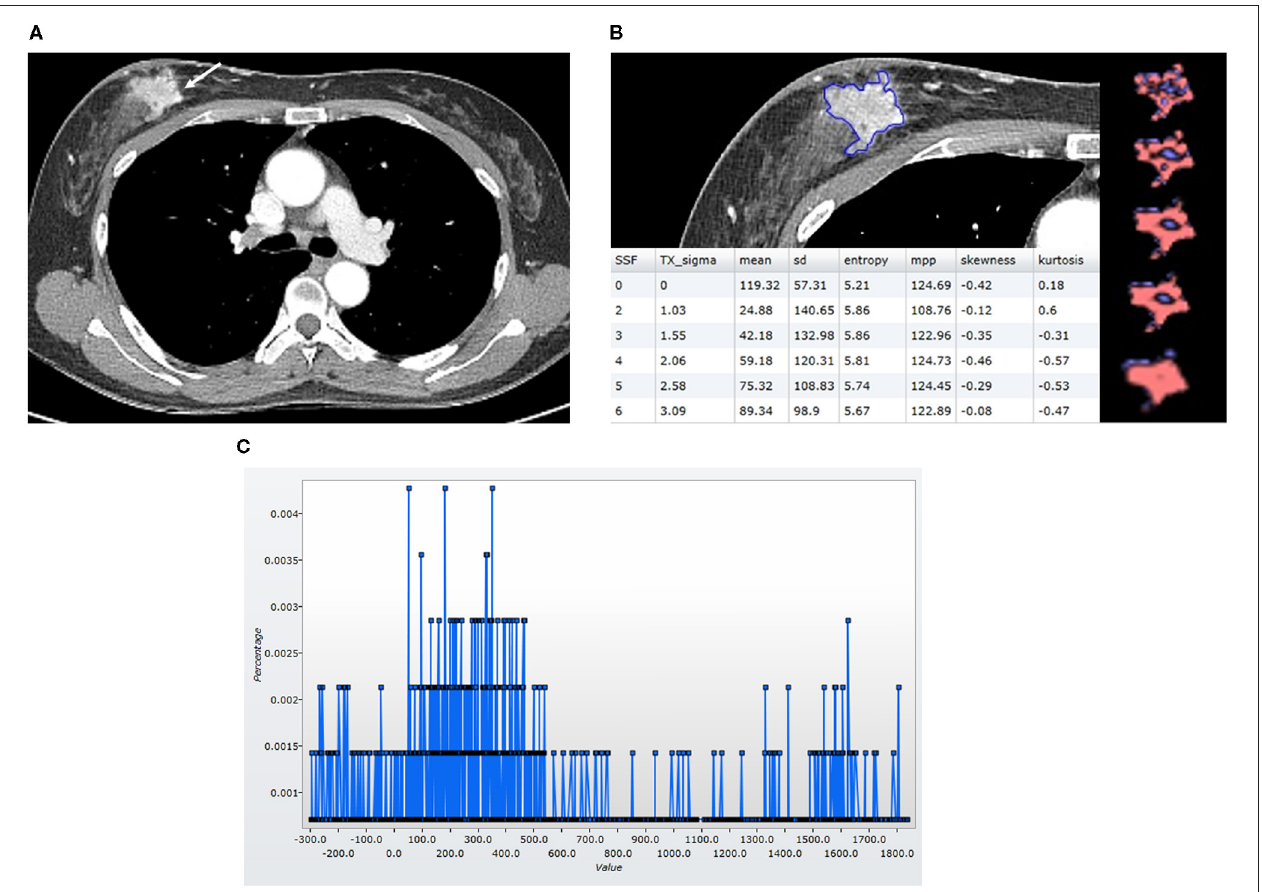
FIGURE 3 | Findings in a 49-year-old woman who was alive 65 months after the diagnosis of luminal-like breast cancer in the right breast. At the time of the diagnosis, she did not have a distant metastasis. (A) An axial post-contrast CT image shows an irregular mass (arrow) with strong enhancement. (B) A texture analysis image shows a region of interest (blue line), texture maps, and texture parameters on the CT image. (C) A CT texture histogram is obtained; from which, the different statistical-based metrics are extracted. Mean, MPP, entropy, and SD were higher for the patient with a good prognosis. MPP, mean of positive pixels; SD, standard